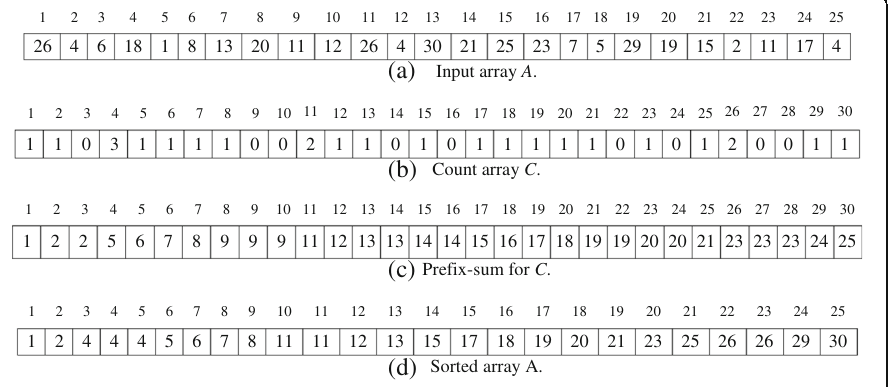
(b) Count array C .